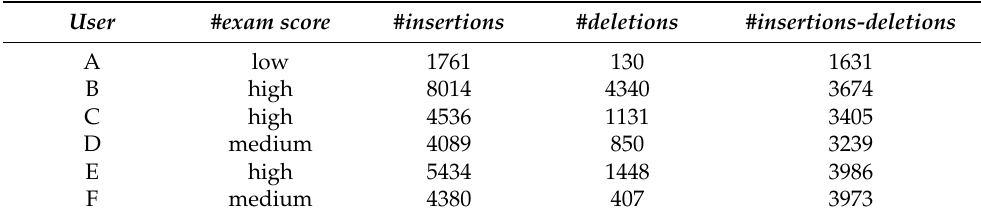
Table 2. Statistics on students’ productivity and their exam scores.